Question: Write a single sentence explaining what this figure depicts.
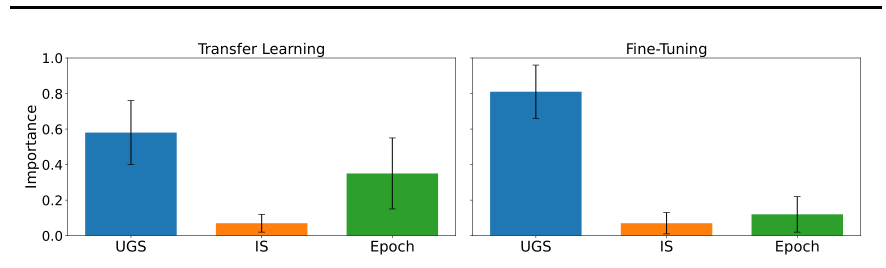
Answer: The hyper-parametes average importance for the two optimisation steps.